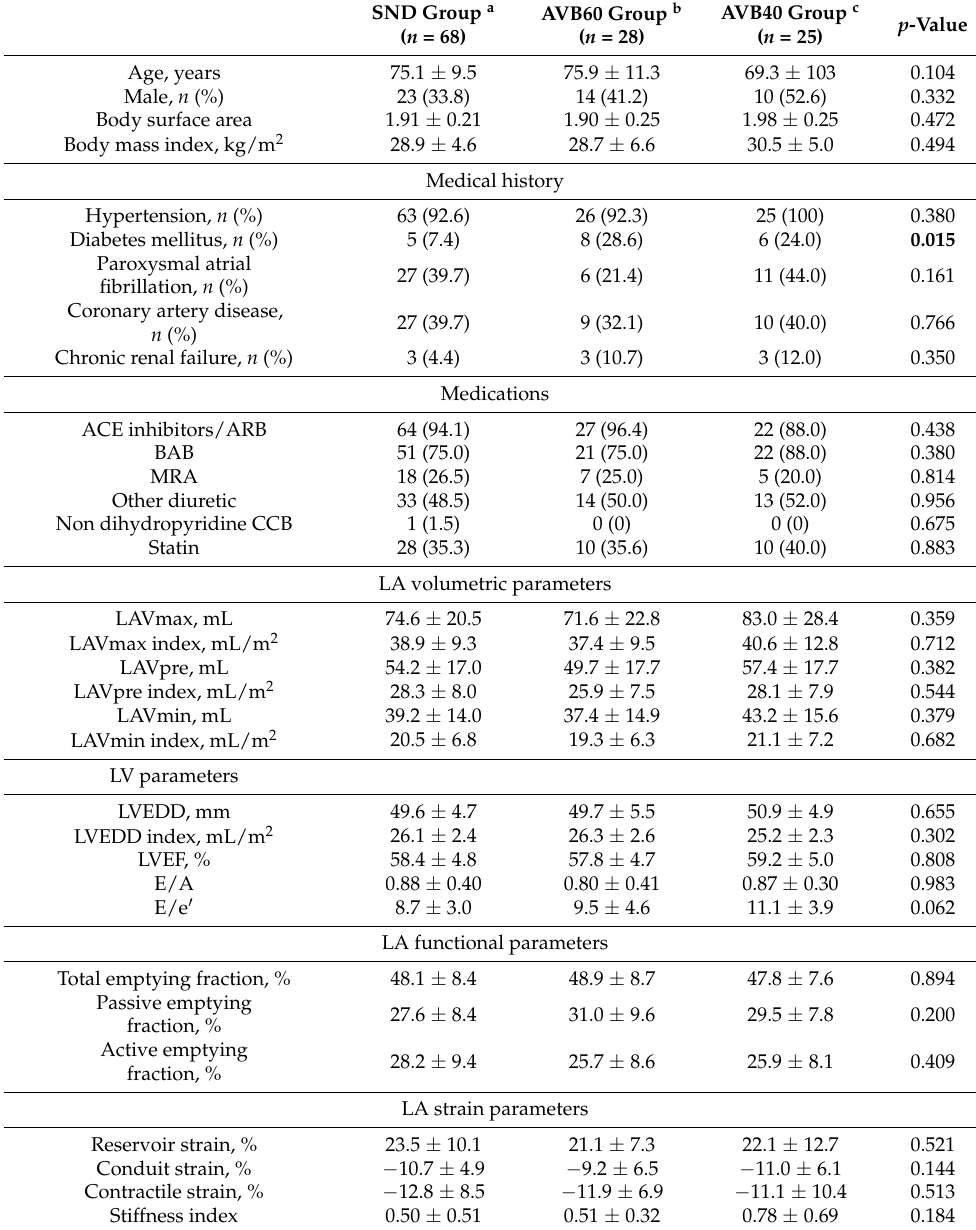
Table 1. Baseline parameters based on indication and base